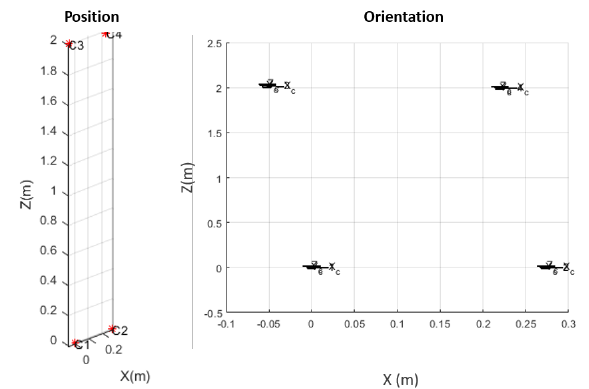
Figure 14. The position and orientation of adjacent image pairs in stereo